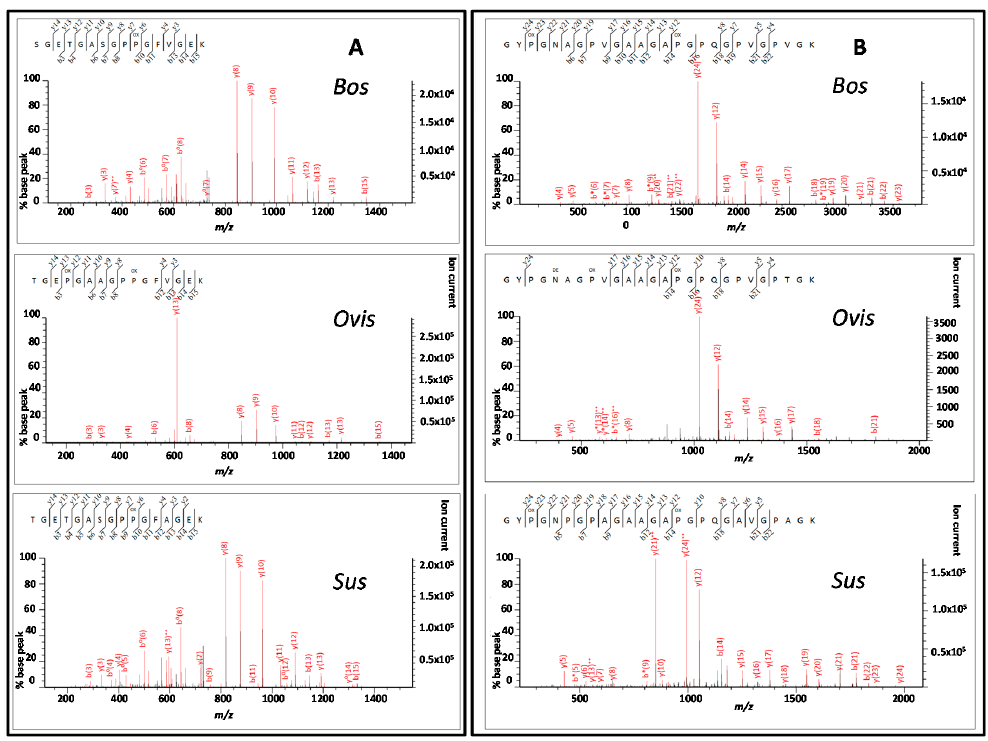
Figure 5. Tandem mass spectra of the two highest scoring α 2(I) chain peptides that are unique to each taxa within this study showing peptides: ( A ) 2t66; and ( B ) 2t74.